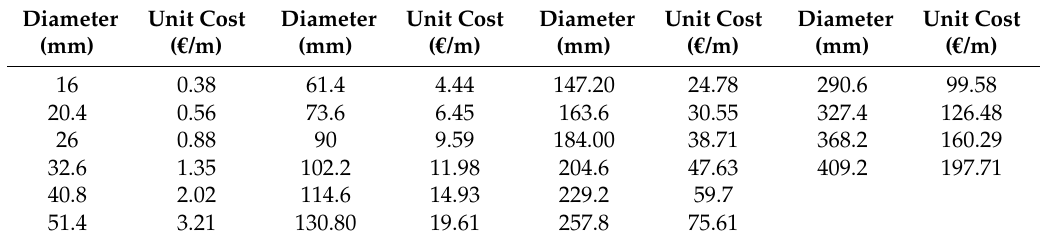
Table 4. Diameter options and associated unit costs of Fossolo network